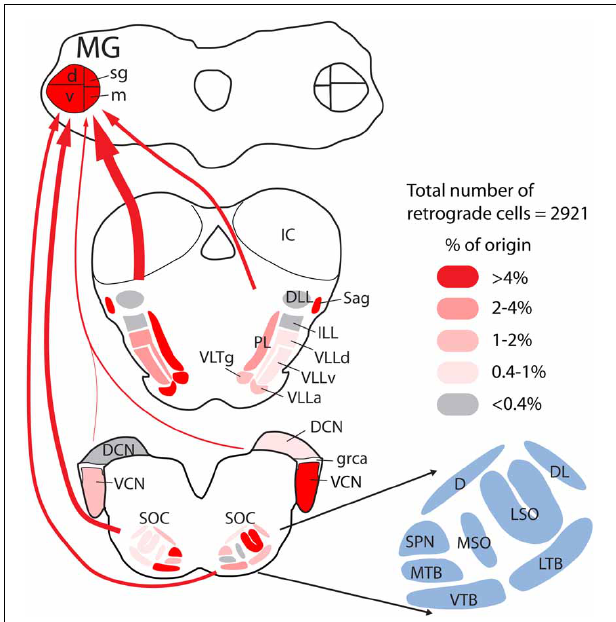
FIGURE 13 | Quantitative graphical summary of the subcollicular projections to the MG. The shading of the nuclei and the thickness of the arrows indicate the relative proportion of retrogradely labeled cells in each nucleus/region after large injections of retrograde tracer into the left MG. Data were analyzed as described for Figure 3 ; additional data for the cochlear nuclei were obtained from a previous study (Schofield et al., 2014) based on the same cases used presently. The percentages of labeled cells in different nuclei ranged from 0 to 16.4%; these values were arbitrarily divided into five categories and shaded as indicated in the legend. Arrows are drawn from groups of nuclei (left or right cochlear nuclei; superior olivary complex, or lemniscal and adjacent tegmental regions), with the thickness of the arrow representing the relative number of labeled cells in each group. Individual nuclei are named in the cross sections or, for the superior olivary complex (SOC), in the adjacent enlargement. See list of